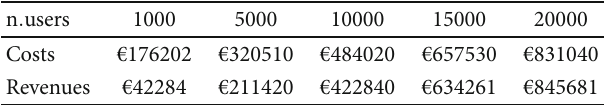
Table 5: CEP costs and revenues per users — 2016.